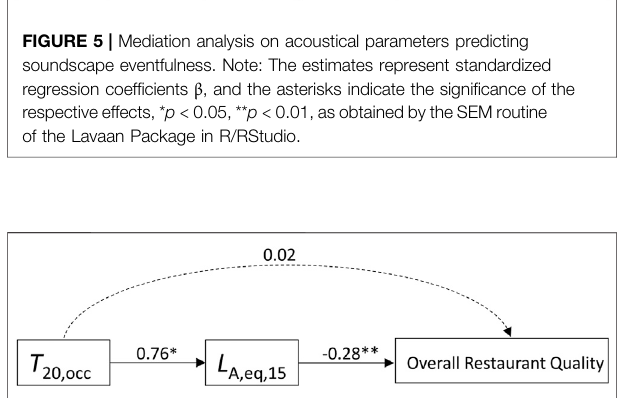
Frontiers in Built Environment |